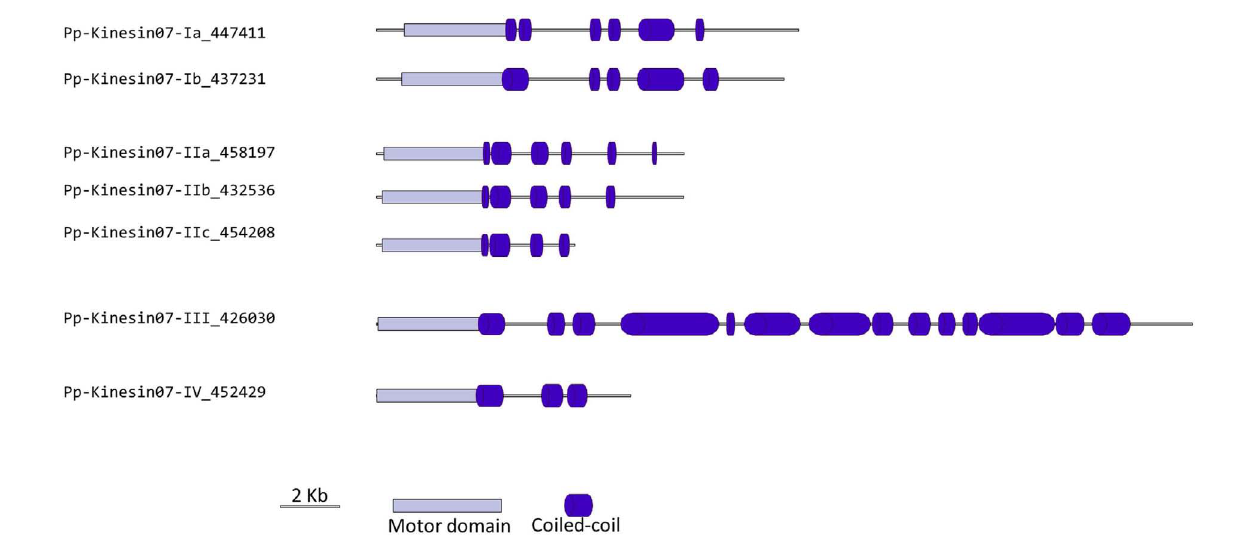
FIGURE 6 | Gene models of kinesin 7s. Schematic diagrams showing the structure and domain architecture of kinesin 7s. Domains are indicated at the bottom of the diagrams.